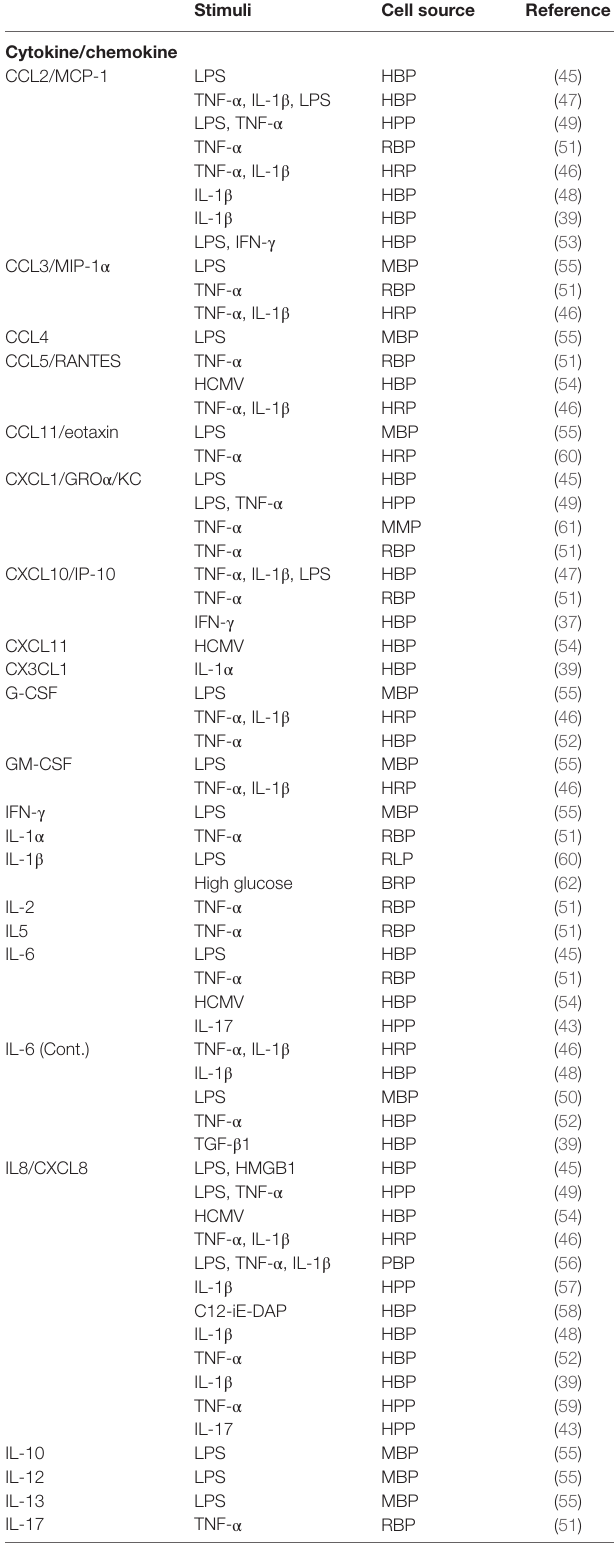
TAbLe 1 | Cytokines, chemokines, and adhesion molecules expressed by pericytes in response to pro-inflammatory